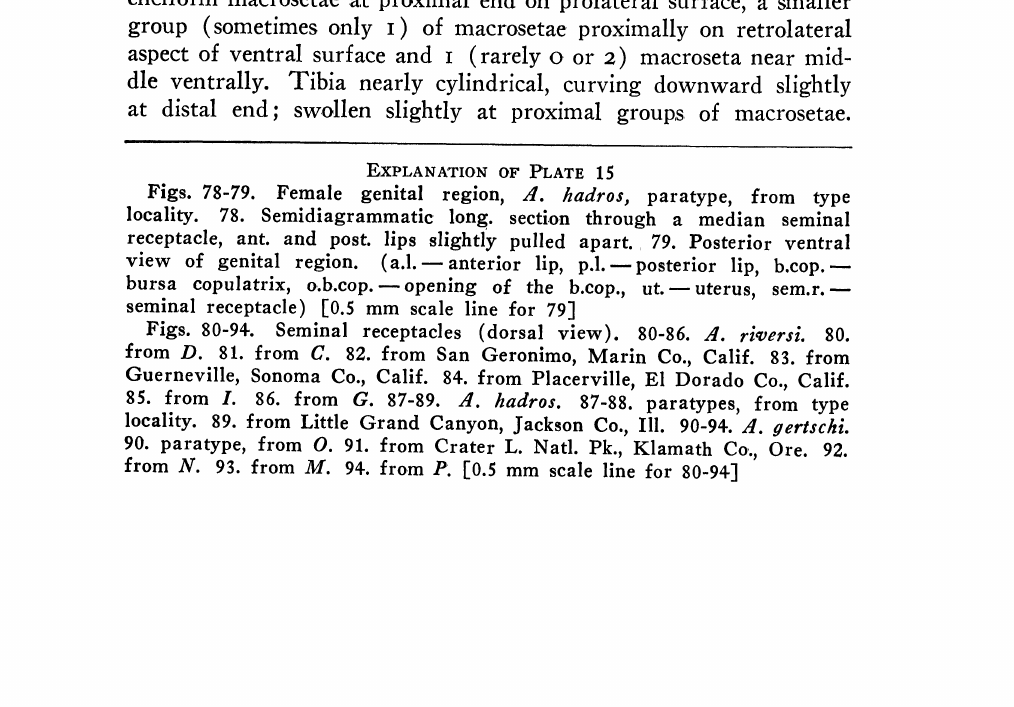
of macrosetae proximally on retrolateral aspect of ventral surface and (rarely o or 2) macroseta near mid- dle ventrally. Tibia nearly cylindrical, curving downwa.rd slightly at distal end; swollen slightly at proximal group.s of